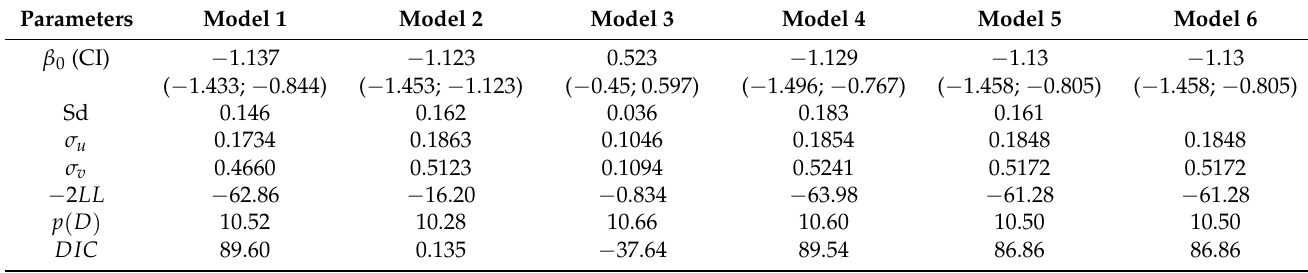
Table 4. A comparison of spatial models for mapping child fever in Mozambique using IMASIDA